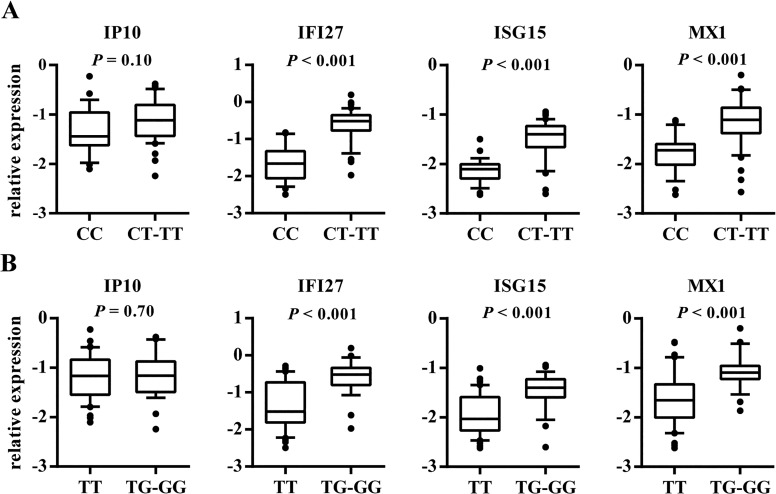
The relationship between IL28B genotypes and expression levels of IP10, IFI27, ISG15, and MX1.The relationship between rs12979860 (A) and rs8099917 (B) genotypes and expression levels of IP10, IFI27, ISG15, and MX1 in the livers of CHC patients is shown. The y-axis shows the relative unit of a given gene, normalized to GAPDH in log scale, as a box plot displaying the 10th, 25th, 50th, 75th, and 90th percentiles of expression levels.